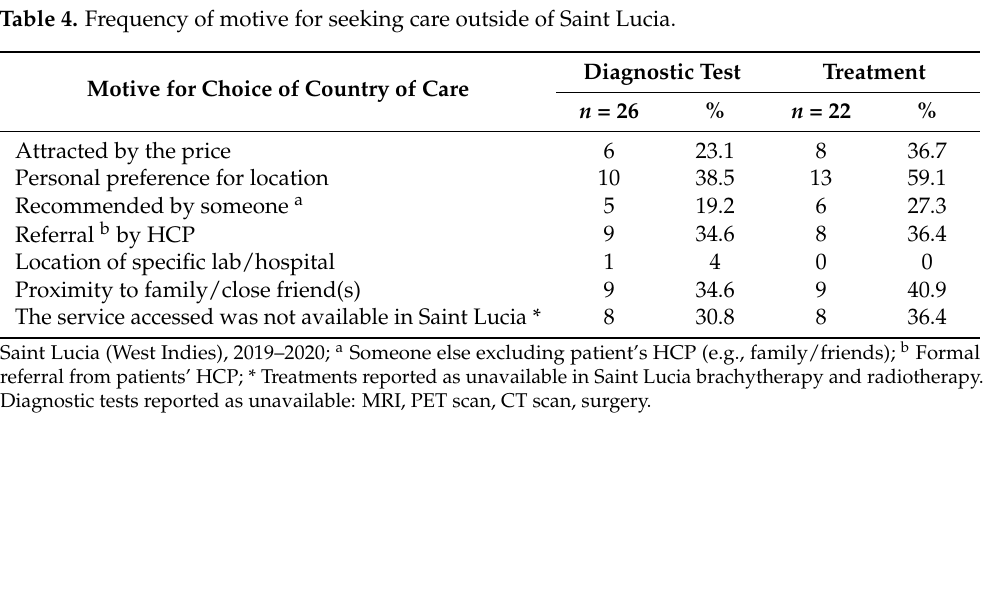
Table 4. Frequency of motive for seeking care outside of Saint